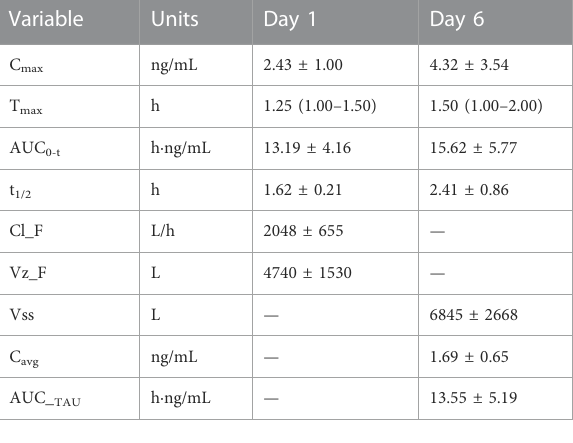
TABLE4Pharmacokineticparametersofschaftosideinhumansubjects(n= 4) after single- and multiple-dose of TFDS Capsules. Data are presented as the mean ± standard deviation except for T max as median (range). Variable